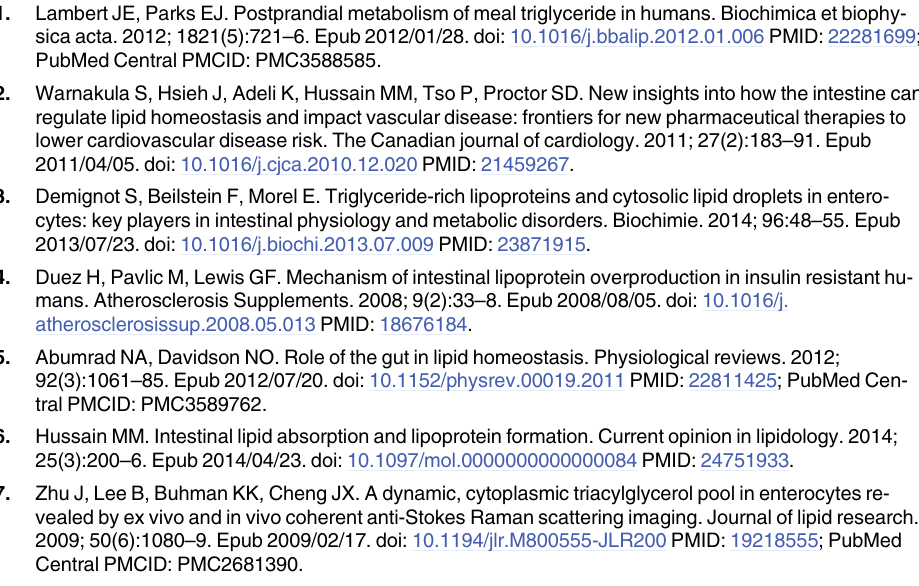
S1 Table. Complete proteome of the CLD fraction isolated from